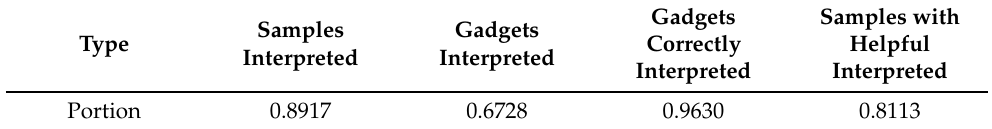
Table 5. Performance of